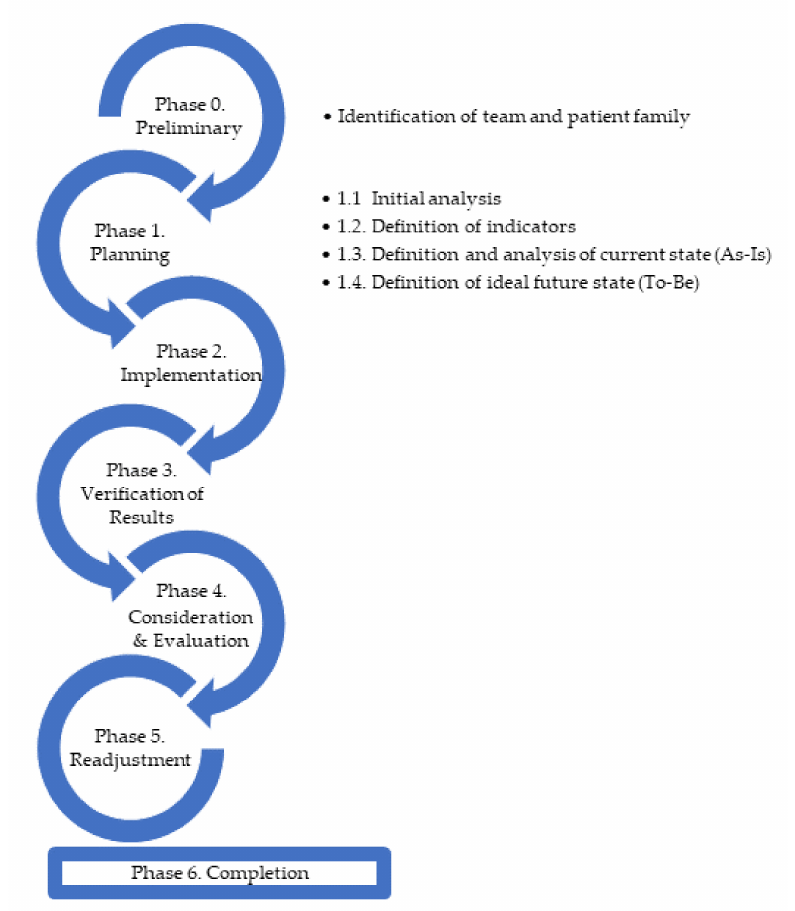
Figure 1. Phases of the Proposed